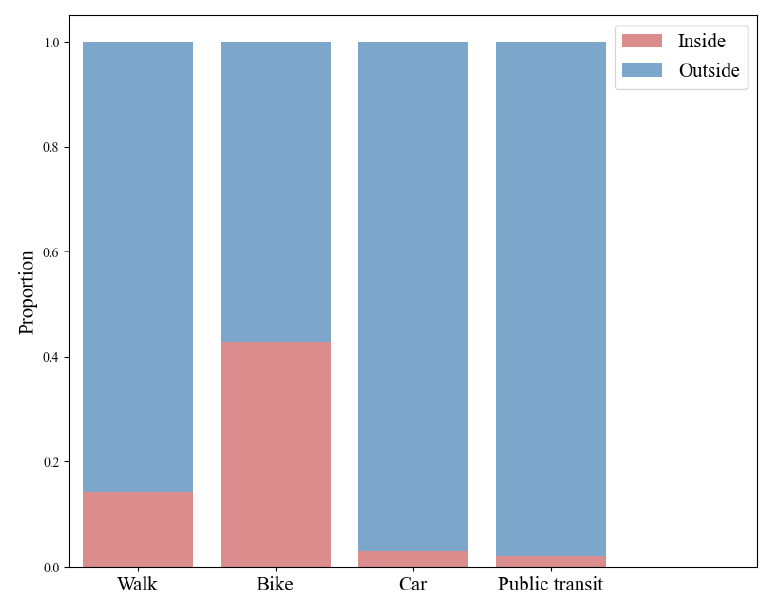
Figure 11. Transportation mode identification by GeoSDVA.